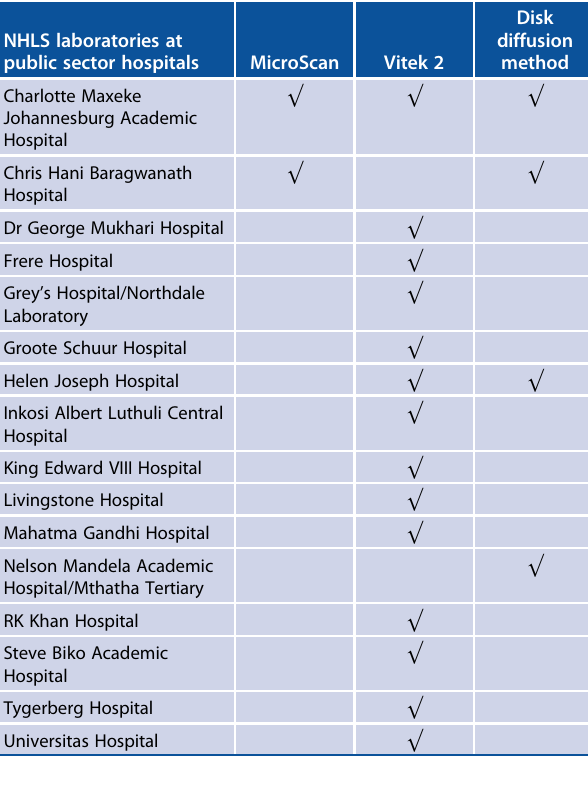
Table 1: List of 16 sentinel hospitals participating in antimicrobial resistance surveillance